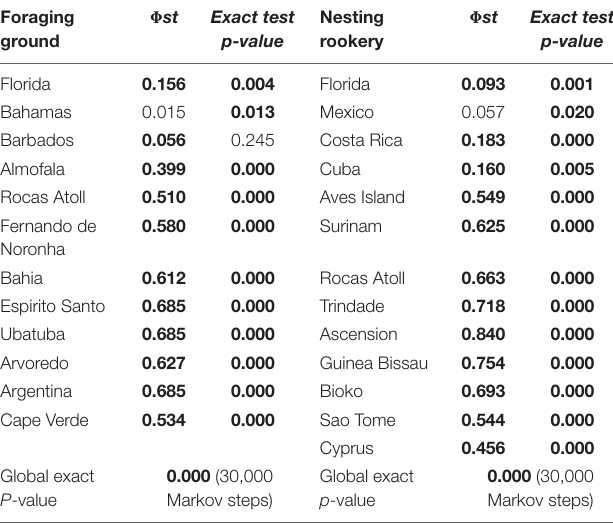
TABLE 2 | Population differentiation ( (cid:56) s ) between Colombia’s stock of Chelonia mydas in La Guajira foraging ground (FG) and stocks in other FGs, as well as in nesting rookeries (NRs) in the Atlantic basin.